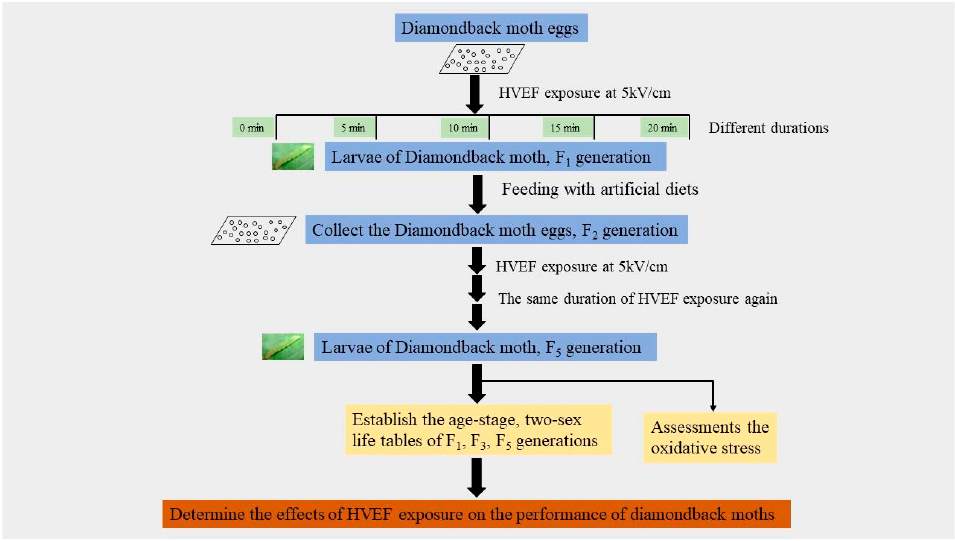
Figure 1. Experimental design for investigating suppression of P. xylostella performance over five generations, in response to direct exposure of eggs to HVEF at 5 kV/cm for different durations. The blue rectangles represent the different stages and generations of P. xylostella concerned in this study. F 1 to F 5 generation represent the first to the fifth generation of P. xylostella. The golden yellow rectangles represent the methods that employed into this study. The orange rectangles represent the main purpose of this study.